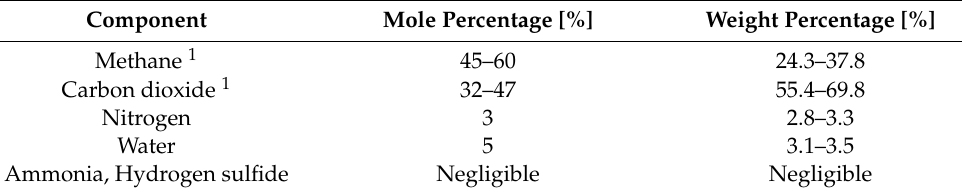
Table 4. Biogas composition (after